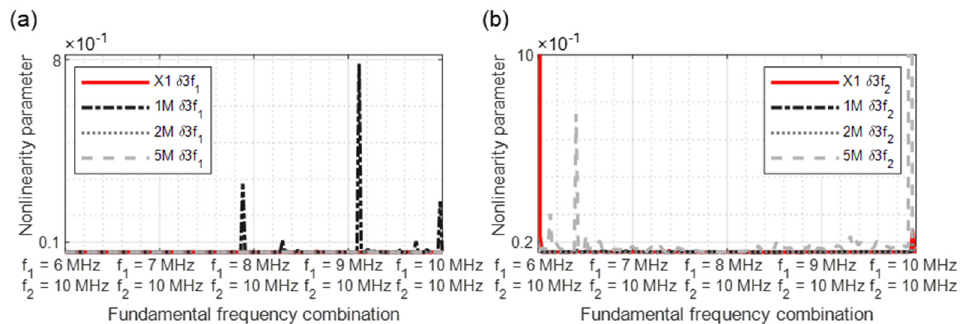
Figure 16. Nonlinearity parameter: ( a ) δ 3f 1 ; ( b ) δ 3f 2 .